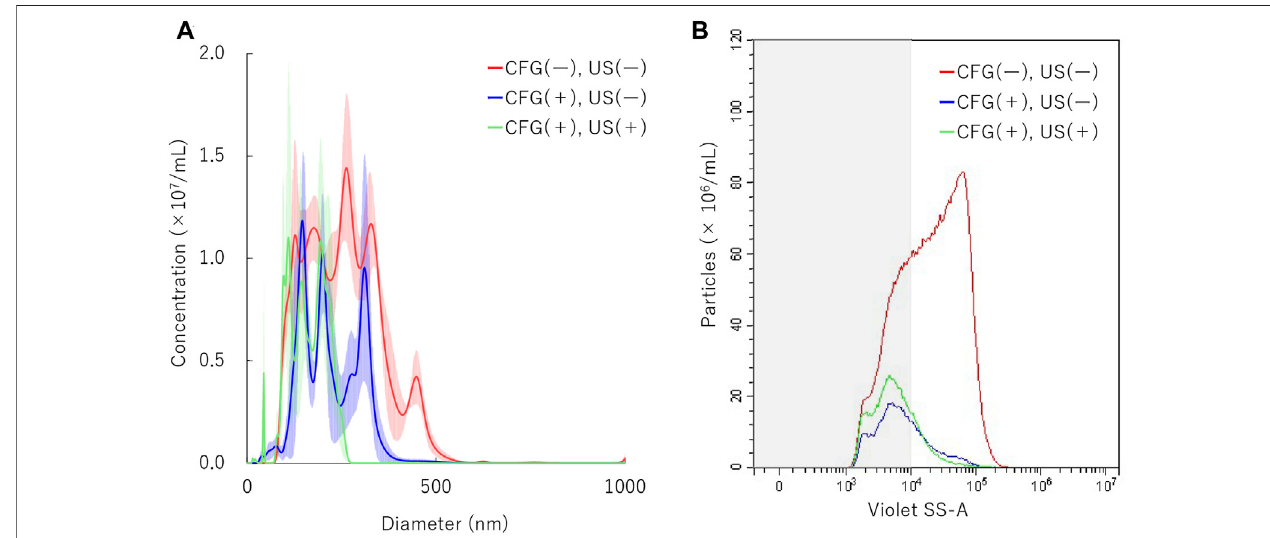
FIGURE6| Nanobubblessizedistributionbycombinationofcentrifugationandsonication. (A) Sizedistributionofnanobubbles(NTA)withorwithoutcentrifugation and sonication (B) The concentrations and distribution of nanobubbles with or without centrifugation and sonication (FCM). CFG, centrifugation. US, ultrasound irradiation. Gray shaded area indicates nanobubbles size less 200